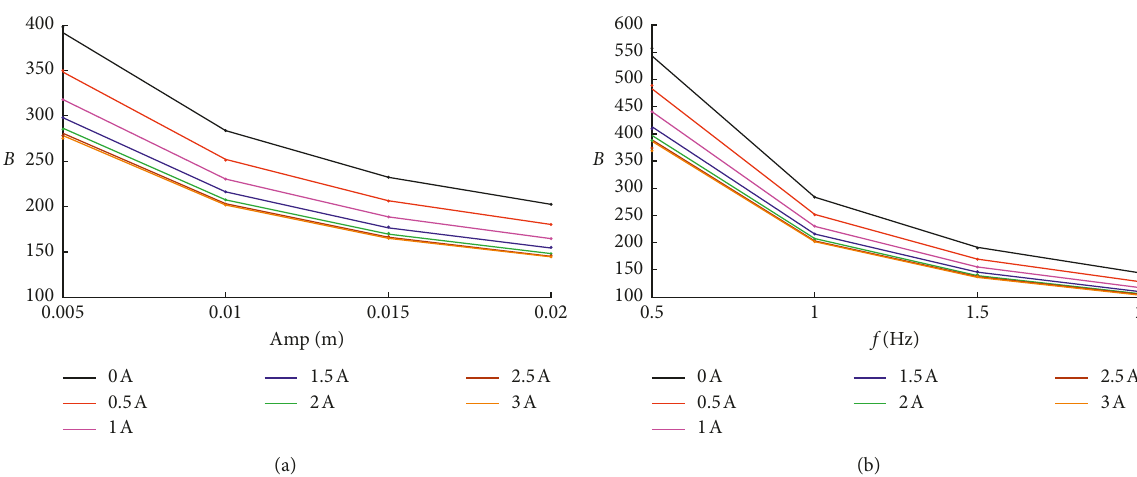
Figure 9: The fitting map of Parameter B and amplitude and frequency. The points represent the experimental values, and the line represents the fitted value. (a) Parameter B and amplitude fit graph. (b) Parameter B and frequency fit graph.